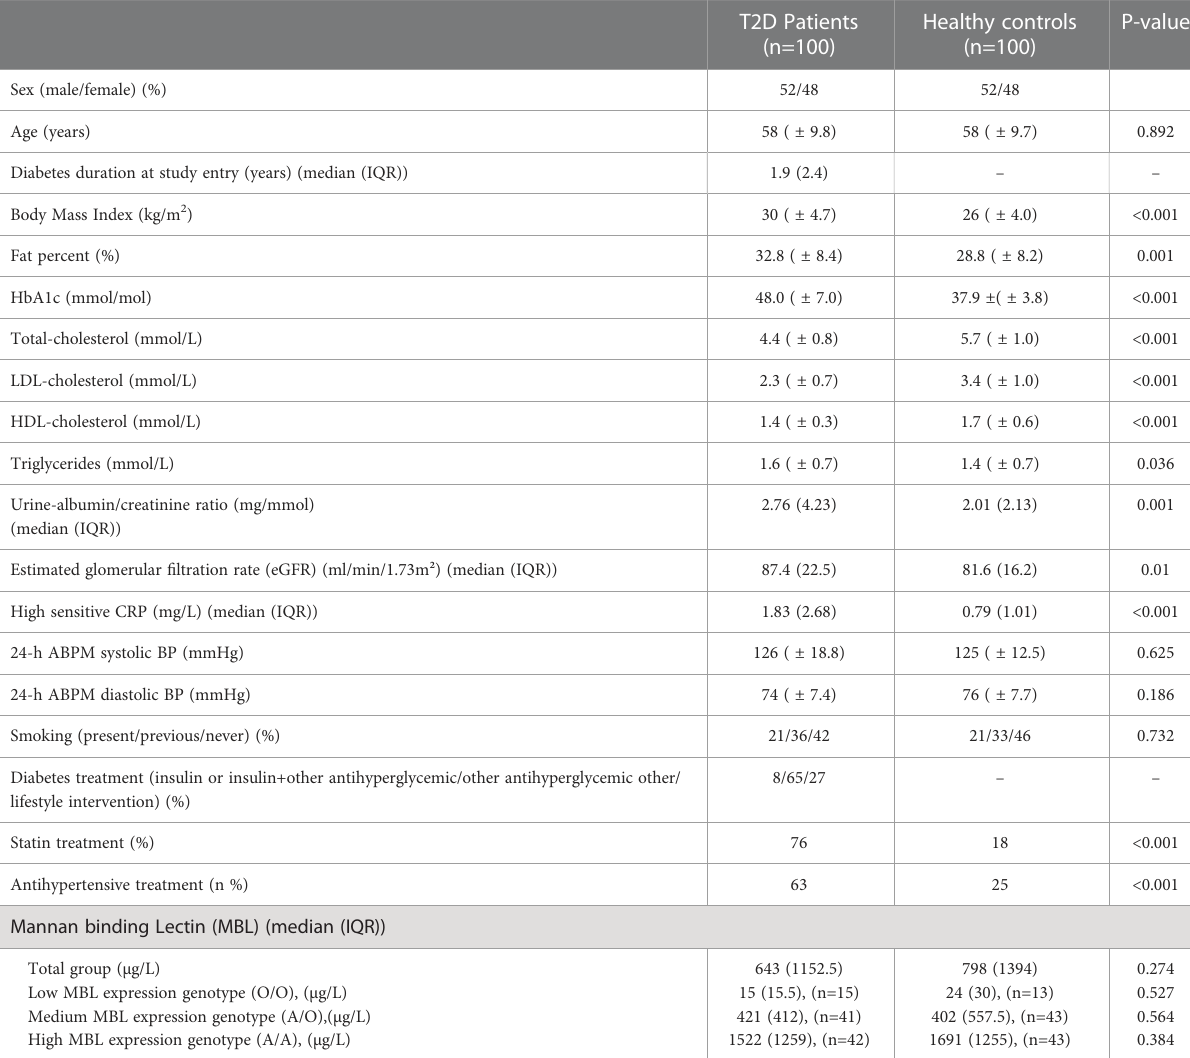
TABLE 1 Characteristics of the participants at study entry. Data are mean ± SD unless other